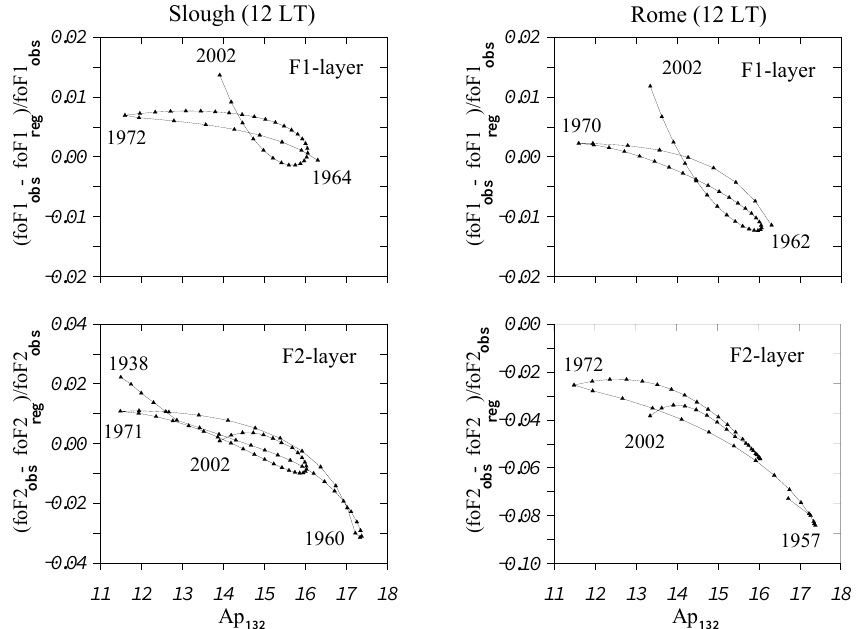
Figure 2 Fig. 2. Relationship of polynomial approximated δ fo F1 132 and δ fo F2 132 with A p 132 for Slough and Rome at